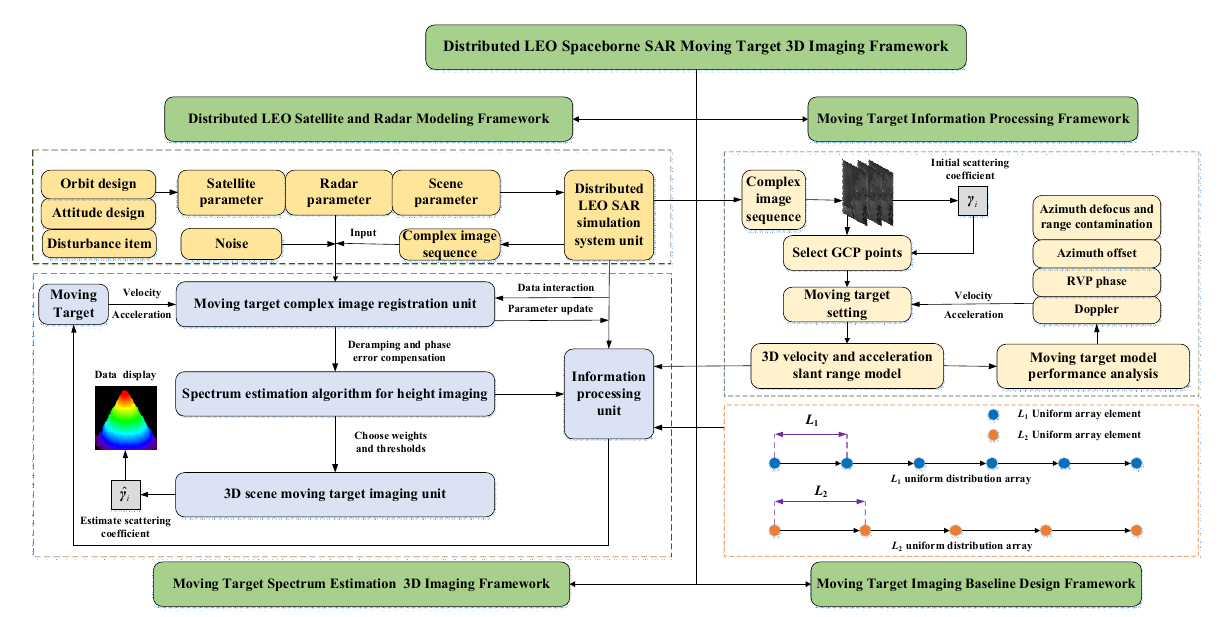
Figure 3. Distributed LEO space-borne SAR moving target 3D imaging framework.